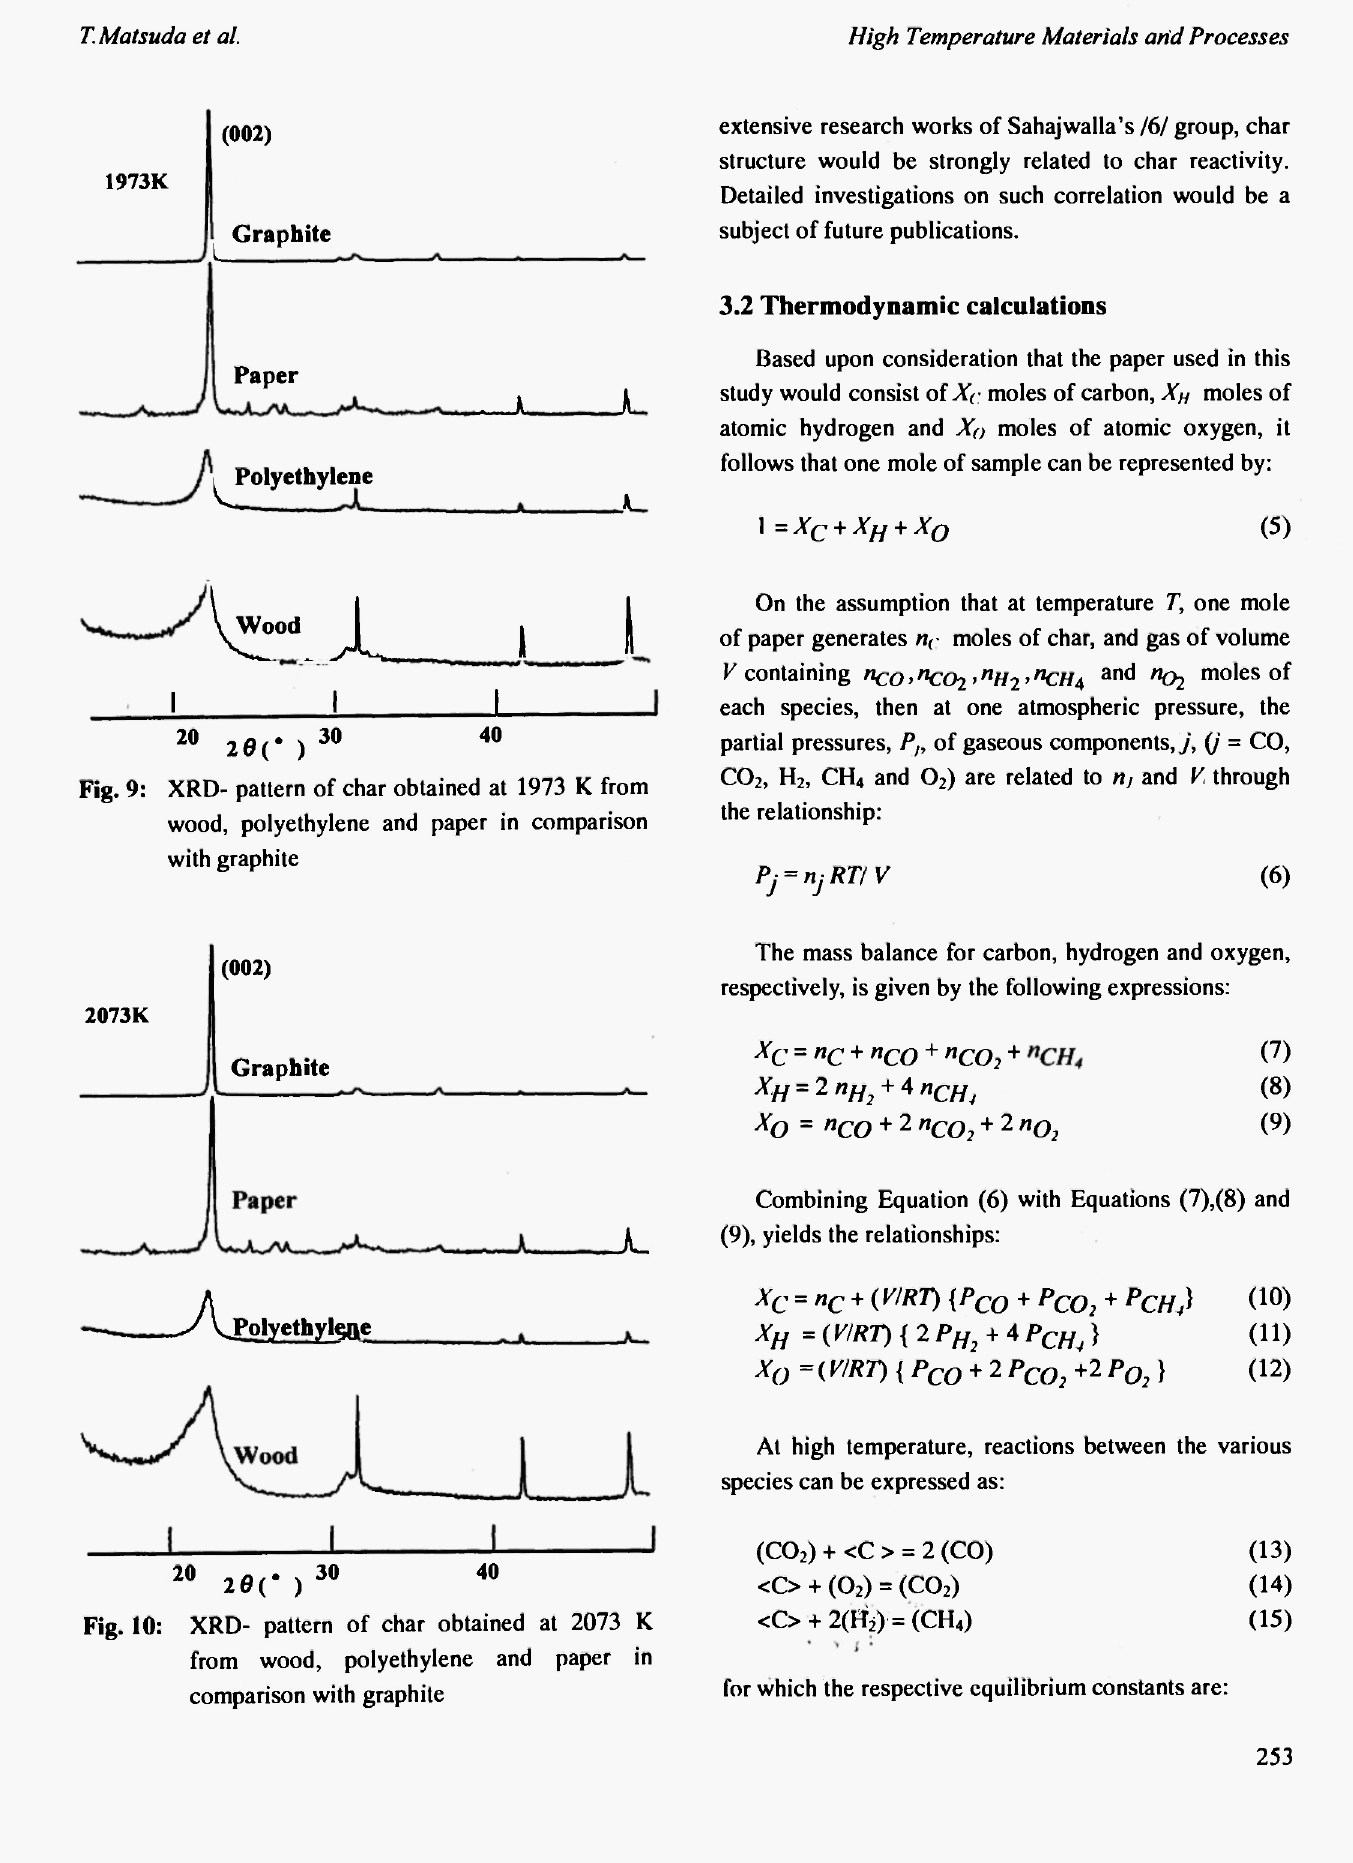
Fig. 9: XRD- pattern of char obtained at 1973 Κ from wood, polyethylene and paper in comparison with graphite